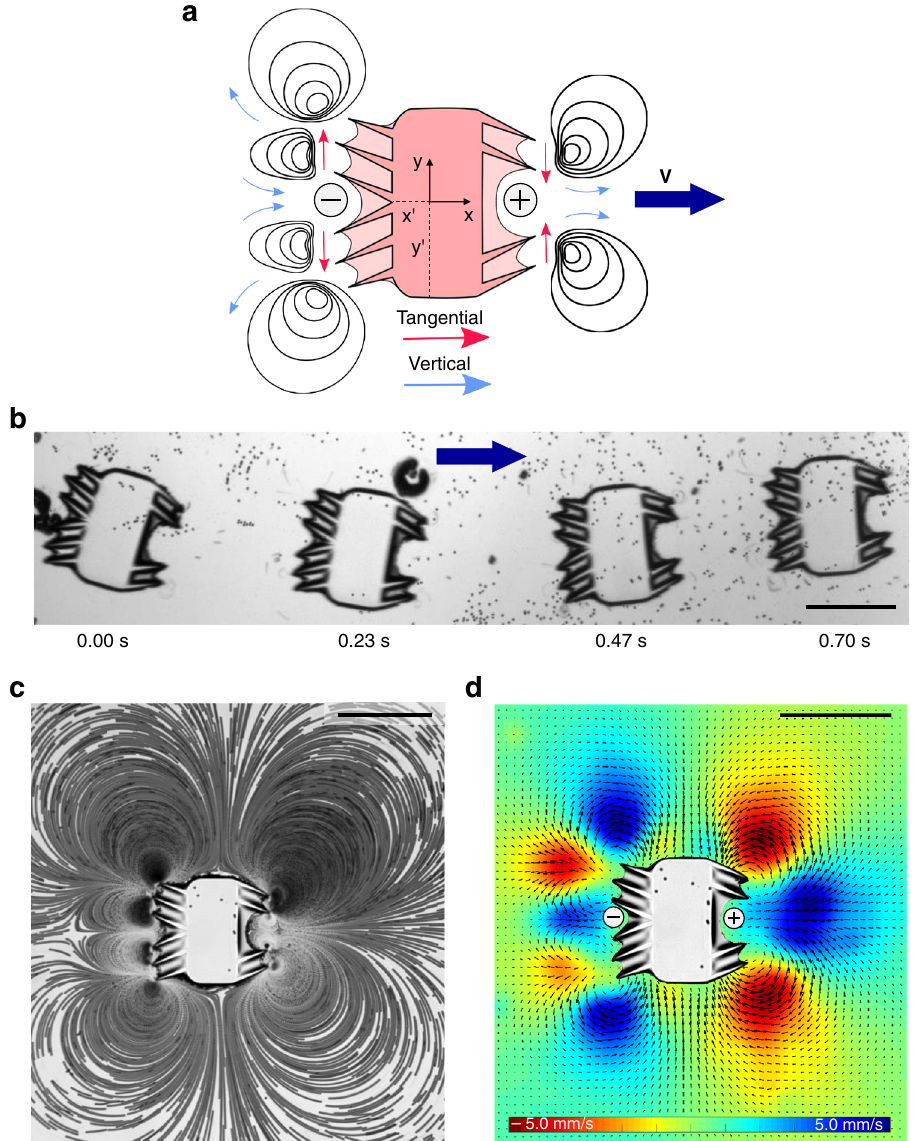
Fig. 4 Propulsion of bioinspired ultrasound microrobot. a Schematic of an arti fi cial microrobot consisting of a – ciliary band on the left and a + ciliary band on the right. Red and blue arrows indicate tangential and vertical velocity, respectively. b Superimposed time-lapse image (time is advancing in the direction of the blue arrow at the values given below) of controlled translation motion of a microrobot at excitation frequency and amplitude of 68.8 kHz and 20 V PP , respectively (see also Supplementary Movie 6). c Image sequence illustrating the streaming fl ow pro fi le of the bioinspired microrobot. A stack of 150 images was used; the video was captured using a high-speed camera at a framerate of 1069 fps (see also Supplementary Movie 7). d PIV generated velocity fi elds demonstrate the complex fl ow behavior developed in the surrounding liquid. Minimum and maximum fl ow velocities are marked by red and blue regions, respectively. Scale bars, 250 μ